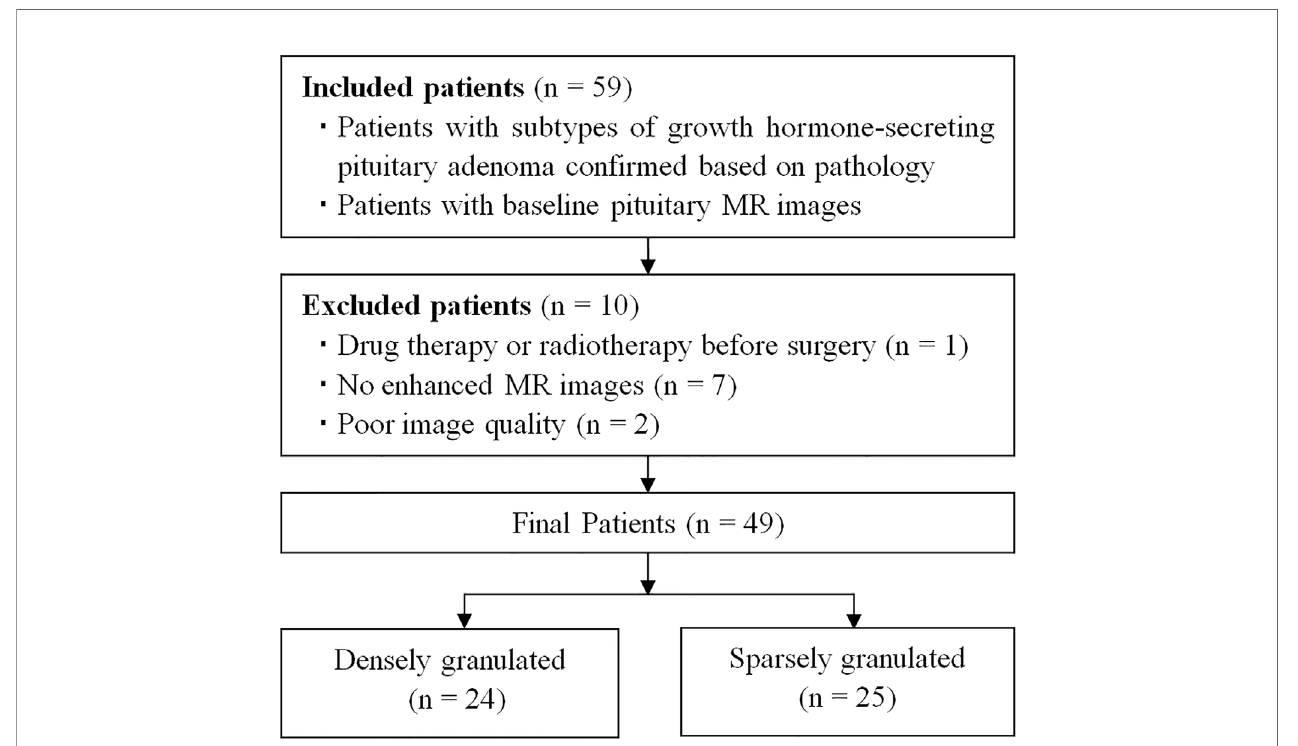
FIGURE 1 | Flow diagram of patient selection and grouping.